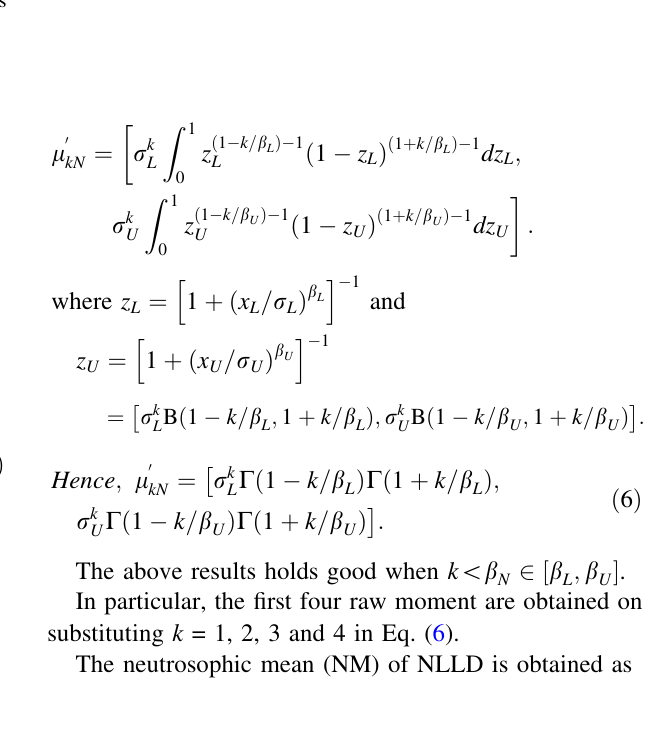
Fig. 2 The cdf curves of NLLD for various neutrosophic